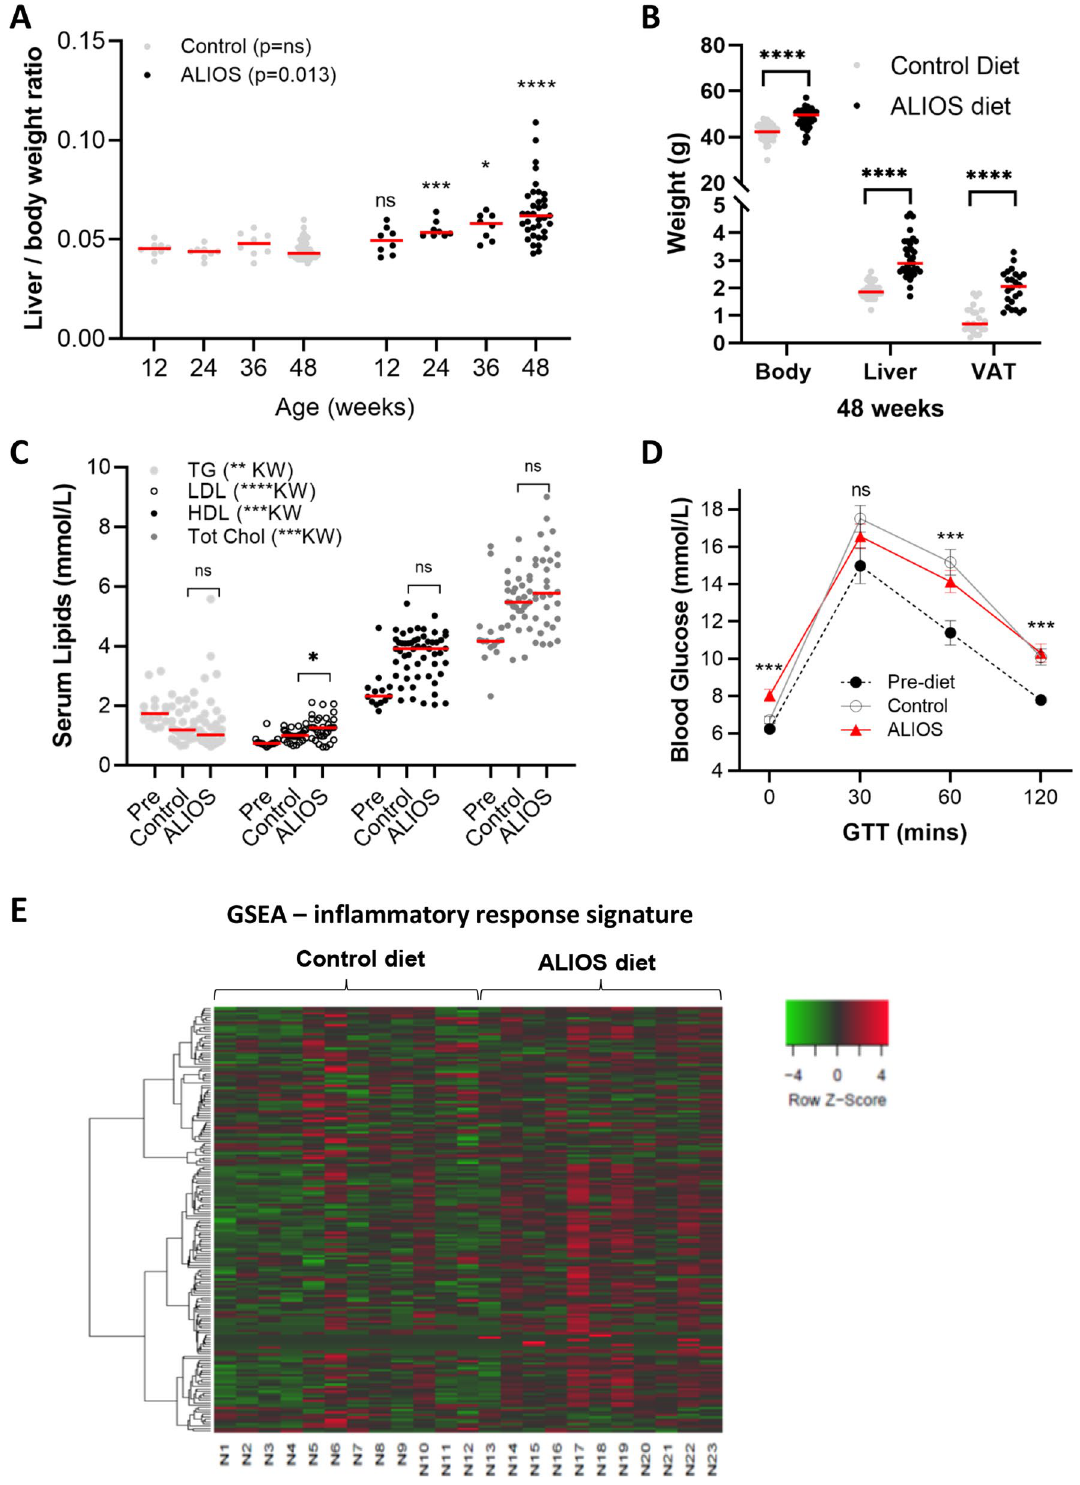
Figure 1. Aged C3H/He mice fed the ALIOS diet develop the metabolic syndrome. Liver/body weight ratio increased with age in ALIOS fed mice ( A ), with elevations in body liver and visceral adipose tissue (VAT) at 48 weeks ( B ). Lipid profiles of 48 weeks mice differed regardless of diet compared to pre diet levels (8 weeks), with low density lipoprotein levels (LDL) being higher in ALIOS fed mice at 48 weeks ( C ). Significant age associated changes during a glucose tolerance test (GTT) in both 48 weeks dietary groups relative to pre-dietary intervention ( D ). The fasting blood glucose was significantly elevated in ALIOS fed mice at 48 weeks ( D ). Data presented as mean ± S.E.M., Statistics using Kruskal Wallis or Mann–Whitney Tests, ns—not significant, *p < 0.05, **p < 0.01, ***p < 0.001, ****p < 0.0001. A heatmap created using heatmapper.ca 42 and an inflammatory response signature including 182 genes shows enrichment in the non-tumour livers of ALIOS fed mice (N13-N23) compaired to controls (N1-N12), as well as heterogeneity within the dietary groups. GSEA—gene set enrichment